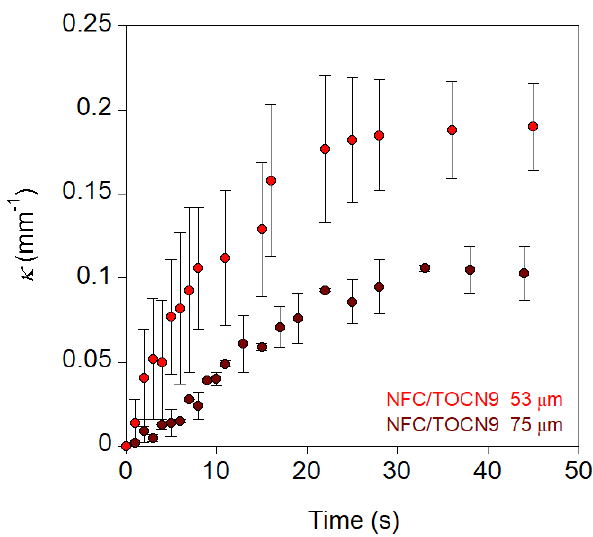
Figure 5. Curvature as a function of time of the NFC/TOCN9 nanopapers with thicknesses of 53 and 75 µm when they were immersed in high pH aqueous solutions (pH 13).